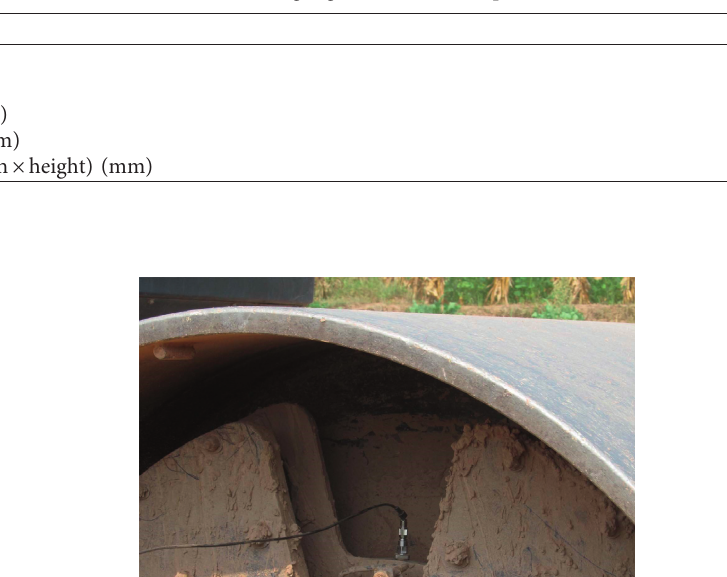
Figure 1: Type A filler and type B filler. The left is type A filler, and the right is type B filler. Table 1: Liugong CLG6126 roller parameters.